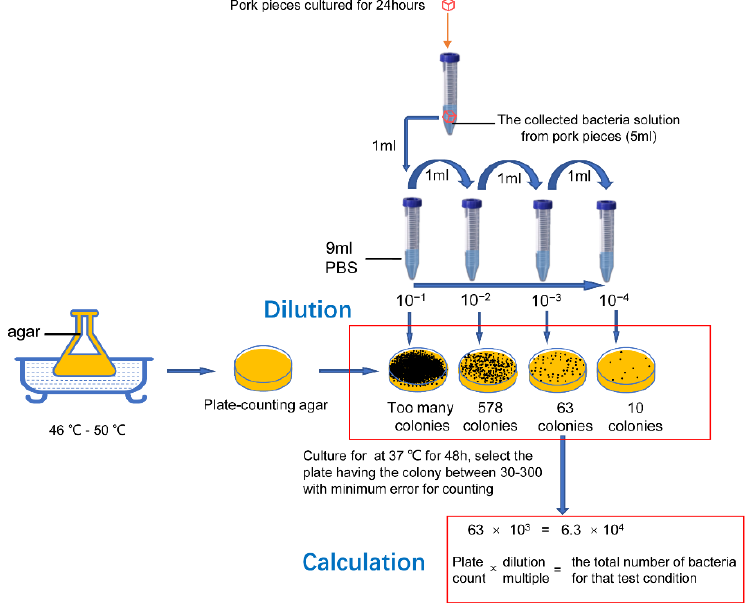
Figure 2. The experimental operation of bacteria collection, cultivation, and counting.